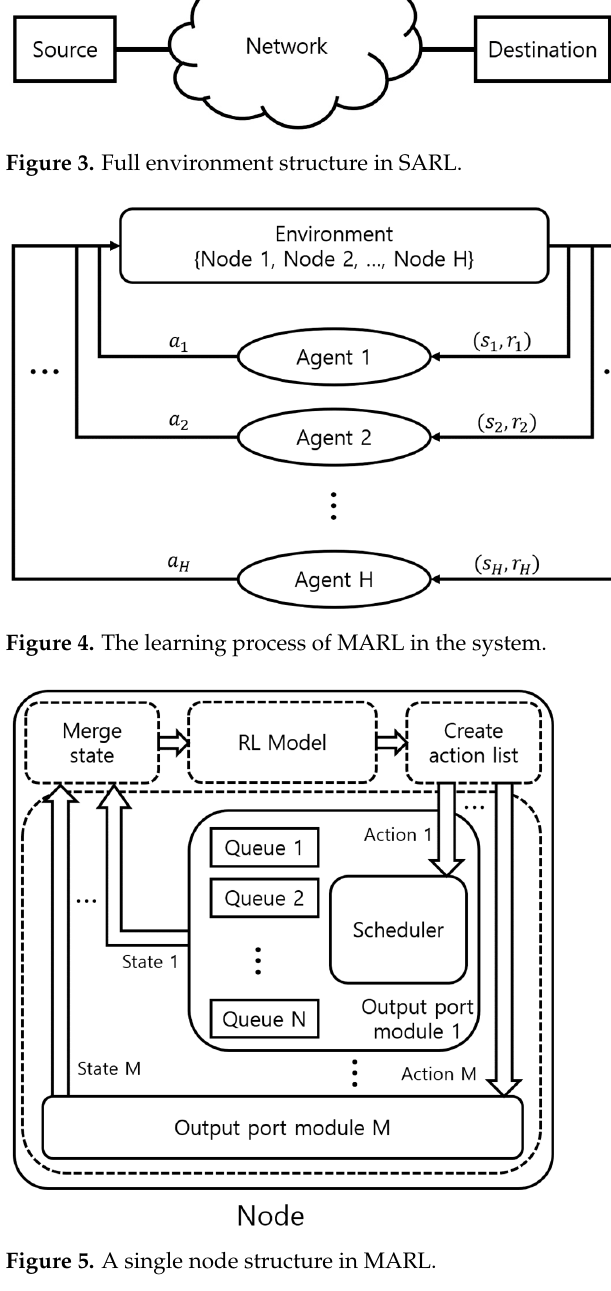
Figure 5. A single node structure in